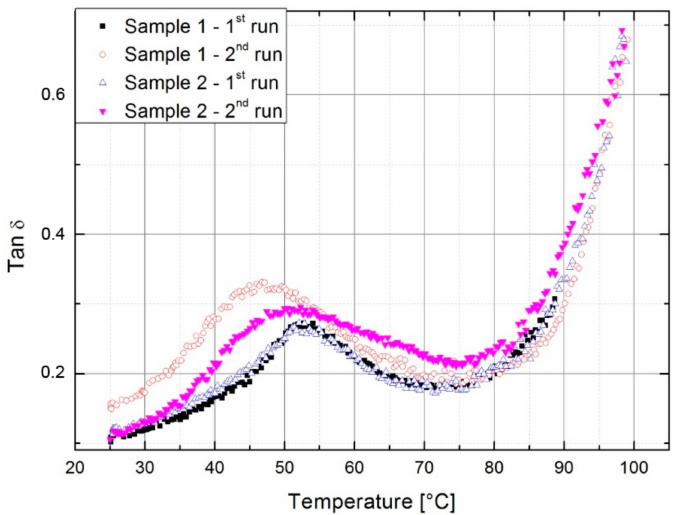
Figure 1. Tan δ of the neat polymer. In the first run the samples were heated either to 89 ◦ C (Sample 1) or 98 ◦ C (Sample